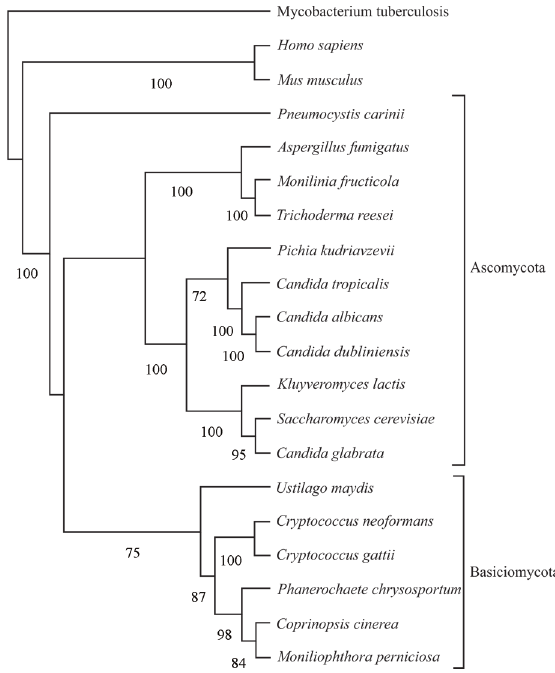
Figure 4 - The most parsimonious tree obtained from the Maximum Parsi- mony analysis based on the amino acid sequence of lanosterol 14 (cid:2) -de- methylase. The numbers below the branches indicate bootstrap support (in %). Length: 2,700